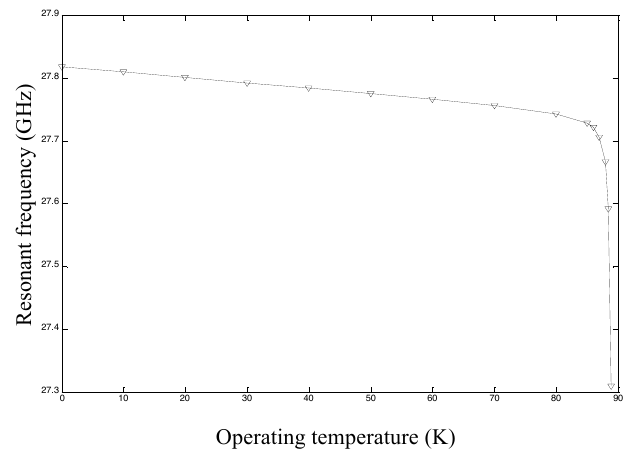
Figure 3: Resonant frequency and bandwidth of the high T superconducting microstrip patch over ground plane c with rectangular aperture against operating